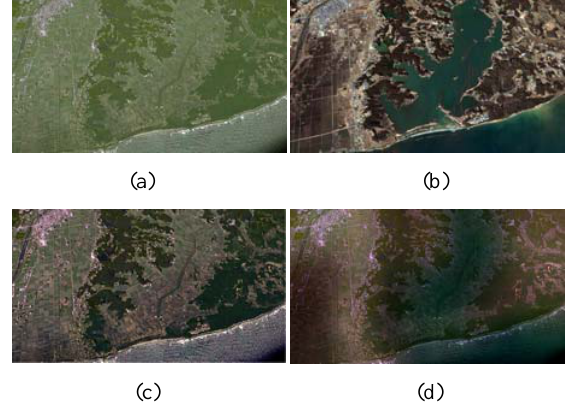
Figure.4 Comparison of Radiometric Pre-processing to Data of Kashimaku in Minamisoma, Japan before and after Disaster, (a)Kashimaku in Minamisoma before Disaster (b)Kashimaku in Minamisoma after Disaster, (c)Relative Radiometric Correction Based on Mean- Variance (d)Relative Radiometric Correction Based on Wavelet Transform and Low-pass